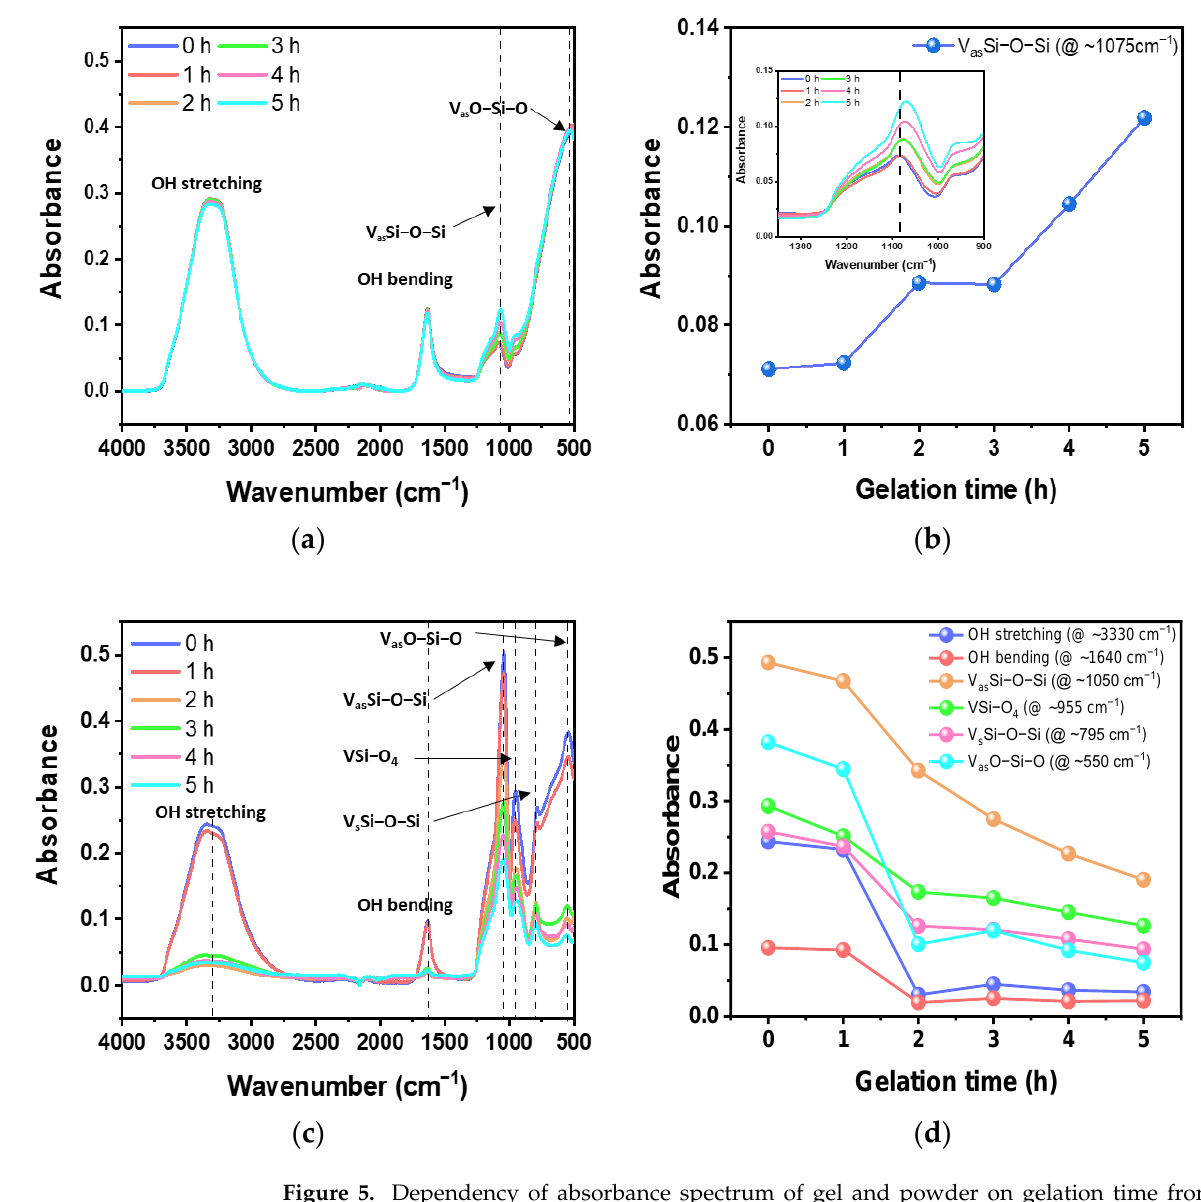
Figure 5. Dependency of absorbance spectrum of gel and powder on gelation time from 0 to 5 h, as analyzed by FT − IR. ( a ) Absorbance spectra of gel at wavenumbers of 500 − 4000 cm − 1 . ( b ) Peak intensity of gel at V as Si − O − Si (~1075 cm − 1 ). The inset is a magnification of the absorbance spectra at wavenumbers of 1350 − 900 cm − 1 ( c ) Absorbance spectra of powder at wavenumbers of 500 − 4000 cm − 1 . ( d ) Peak intensity of powder at the OH stretching (~3330 cm − 1 ), OH bending (~1640 cm − 1 ), V as Si − O − Si (~1100 cm − 1 ), VSi − O 4 (~950 cm − 1 ), V s Si − O − Si (~790 cm − 1 ), and V as O − Si − O (~550 cm − 1 ) peaks. The quartz powder samples were synthesized through the freezing, thawing, and drying of the gel samples used in Figure 5a. Six main peaks appeared in the absorbance spectrum of the quartz powder samples, as shown in Figure 5c, i.e., a broad OH stretching peak at ~3300 cm − 1 derived from the OH group, an OH bending peak at ~1640 cm − 1 , an asymmetric Si − O − Si vibration (V as Si − O − Si) peak at ~1050 cm − 1 , a Si − O 4 vibration peak (VSi − O 4 ) at ~955 cm − 1 , a symmetric Si − O − Si vibration (V s Si − O − Si) at ~795 cm − 1 , and an asymmetric O − Si − O bending (V as O − Si − O) peak at ~550 cm − 1 [30]. The change